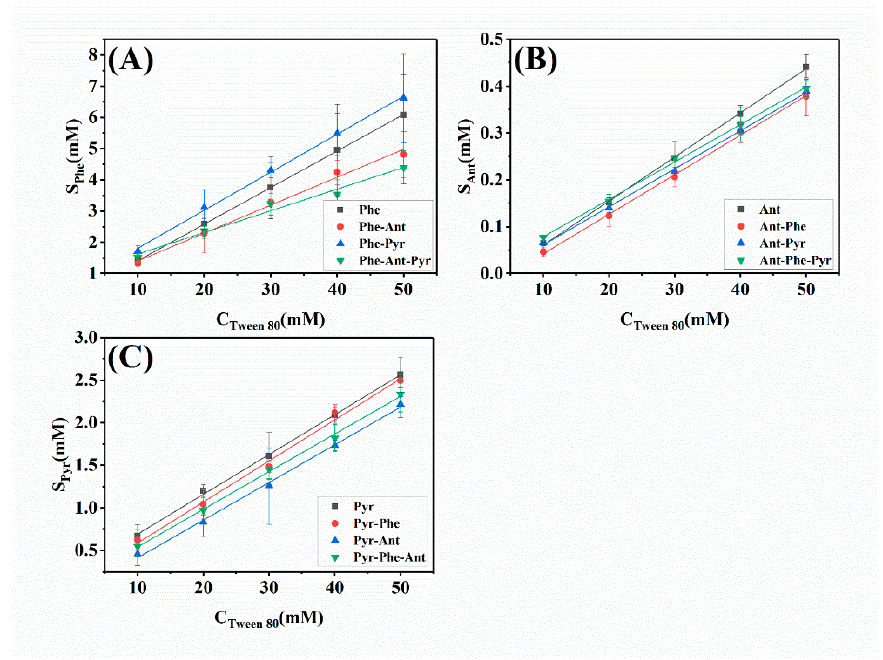
Figure 1. The apparent solubility (S) of Phe ( A ), Ant ( B ) and Pyr ( C ) in single, binary or ternary states in Tween 80 micellar solutions. The apparent solubility is shown as the mean and the standard deviation of three measurements.